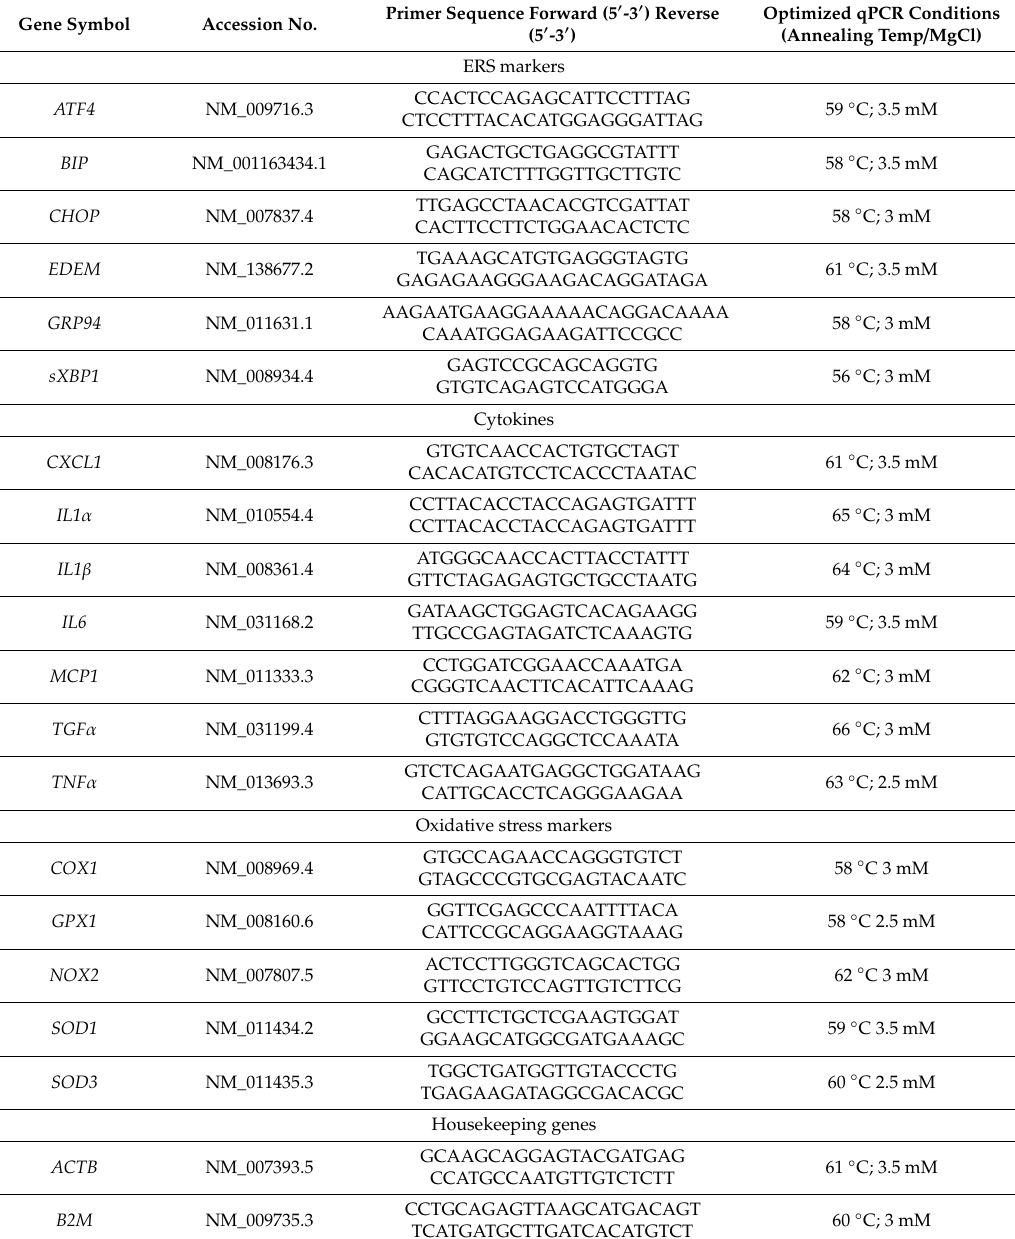
Table 1. Oligonucleotides used for qPCR